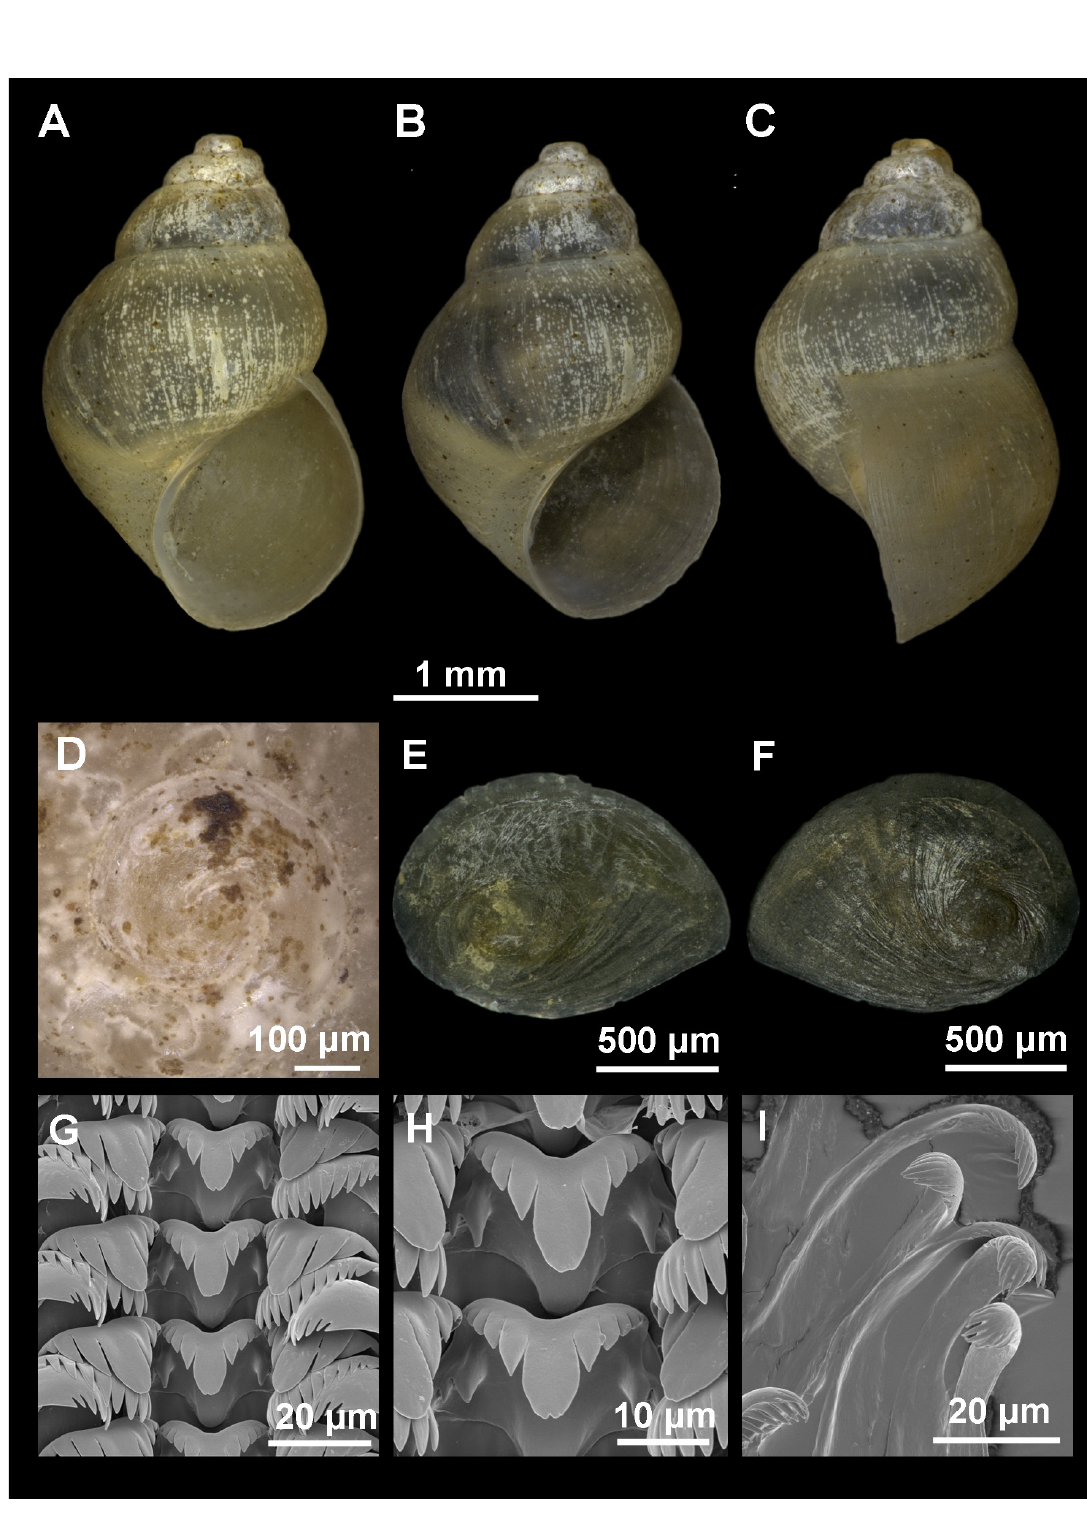
Fig. 4. Shell, operculum and radula of Intermaria kermanshahensis (Glöer & Pešić, 2009) gen. et comb. nov. from a spring near Sarabe - Sahneh city, Kermanshah Province, Iran. A–B . Shell in front view. C . Shell in lateral view. D . Protoconch and microsculpture. E–F . Internal and external side of the operculum. G . Rows of teeth of the radula. H . Central teeth. I . Detail of outer marginal